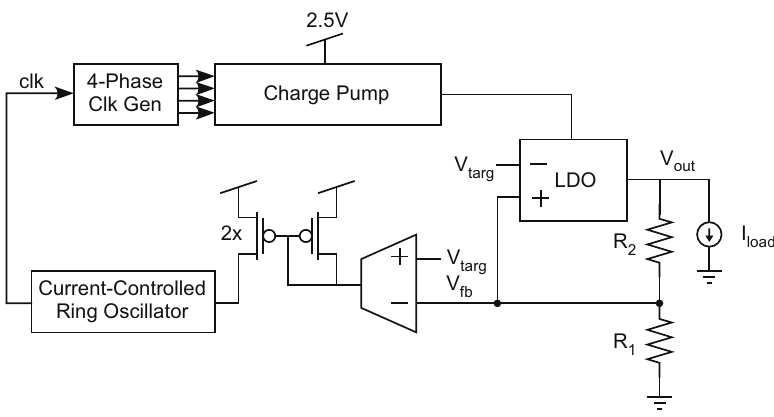
Figure 3. Block diagram of the proposed low-output-ripple charge